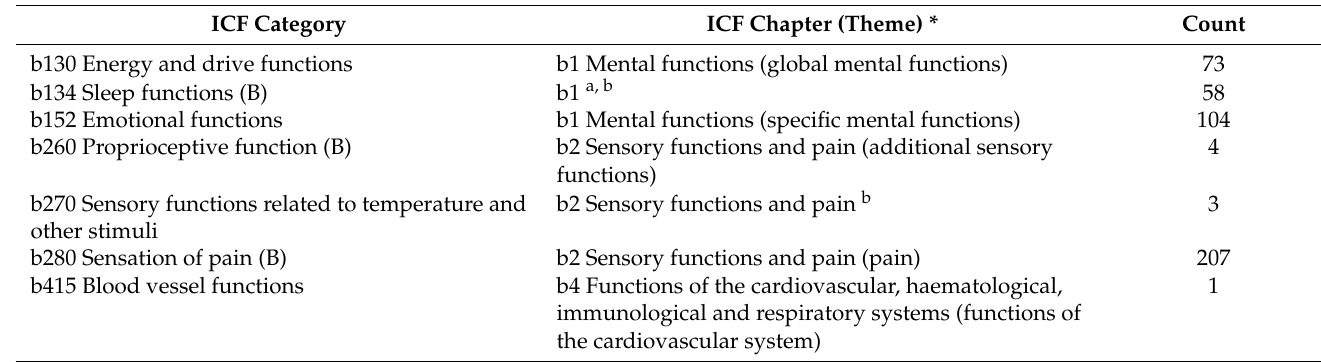
Table A3. Comparison with the Comprehensive ICF Core Set for Post-Acute Musculoskeletal